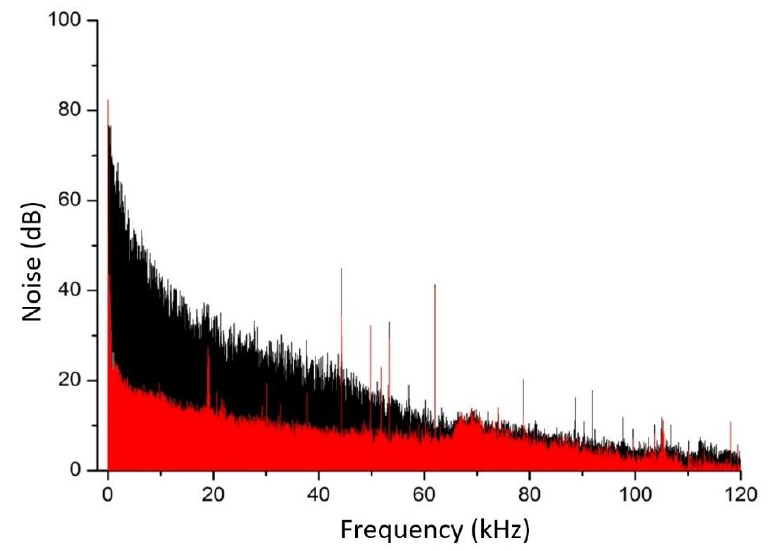
Figure 2. Spectra of the photocurrent noises; plastic disk off (red trace), plastic disk on (black trace). The efficiency of the new data processing algorithm is shown in Figure 3. The figure shows 3D images of raw data (signals from the photodetector PDs) registered in the DAS mode (a) and using the log-WMS-1 f technique (b) for a temperature of 1050 K.